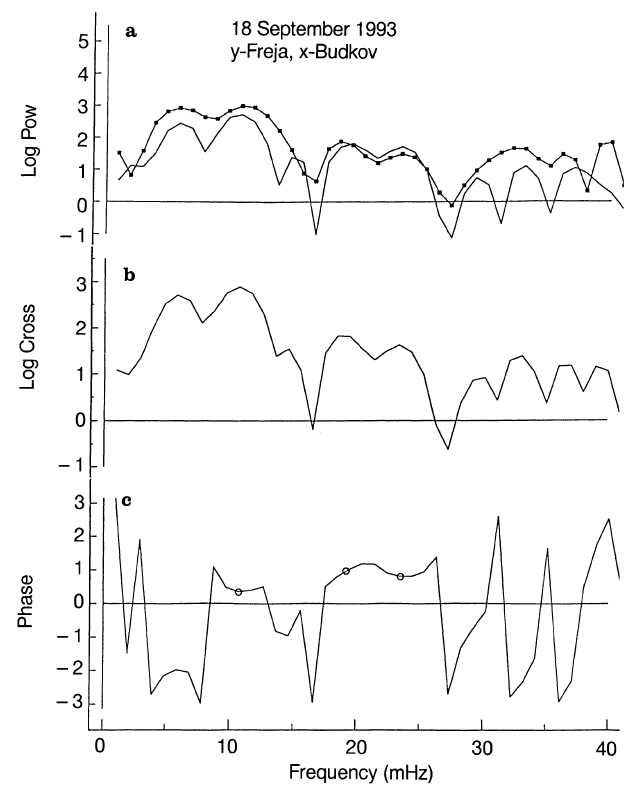
Fig. 5a–c. Frequency dependences for the event of 18 Sept. 1993, analogous to Fig. 2 for y -Freja and x -Budkov records: a the power- spectra, b the real modulus of the cross-spectrum (both on lognT 2 = Hz), c the cross-spectral phase